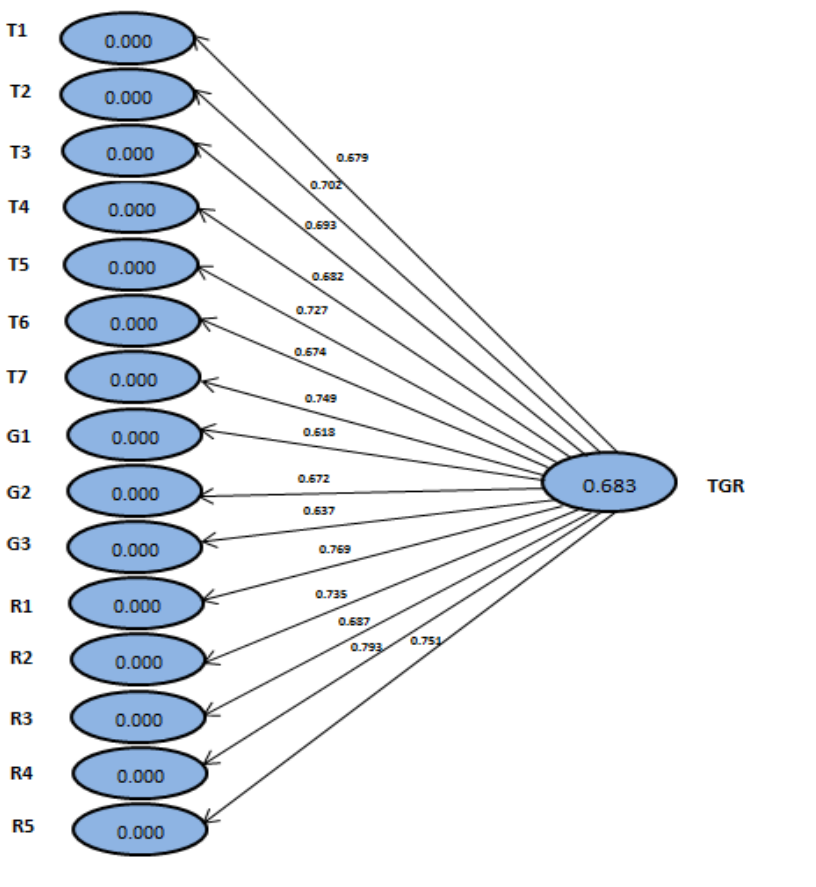
Fig. 4. The path coefficients and factors